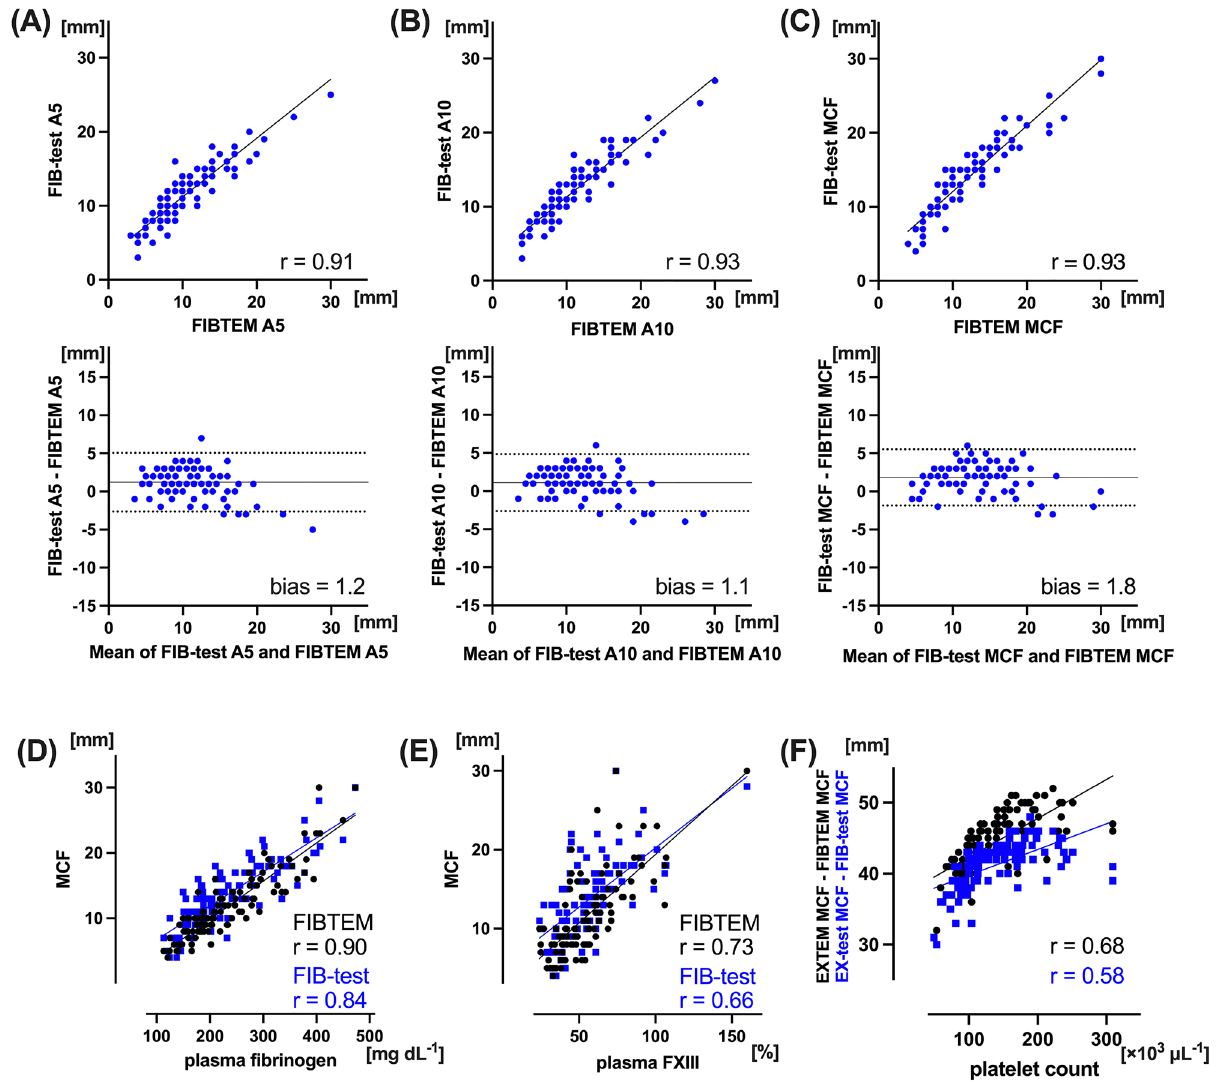
Figure 5. Relationship between FIB-test and FIBTEM. Linear regression and Bland–Altman analysis of clot firmness, between FIB-test and FIBTEM; A5 ( A ), A10 ( B ), and MCF ( C ). Linear regression between FIB-test/ FIBTEM MCF and plasma fibrinogen ( D ), or plasma FXIII ( E ). Linear regression between platelet count and difference between EX-test MCF and FIB-test MCF, or EXTEM MCF and FIBTEM MCF ( F ). Solid line in Bland–Altman analysis depicts bias, and dotted lines depict 95% limits of agreements. MCF maximum clot firmness, FXIII factor